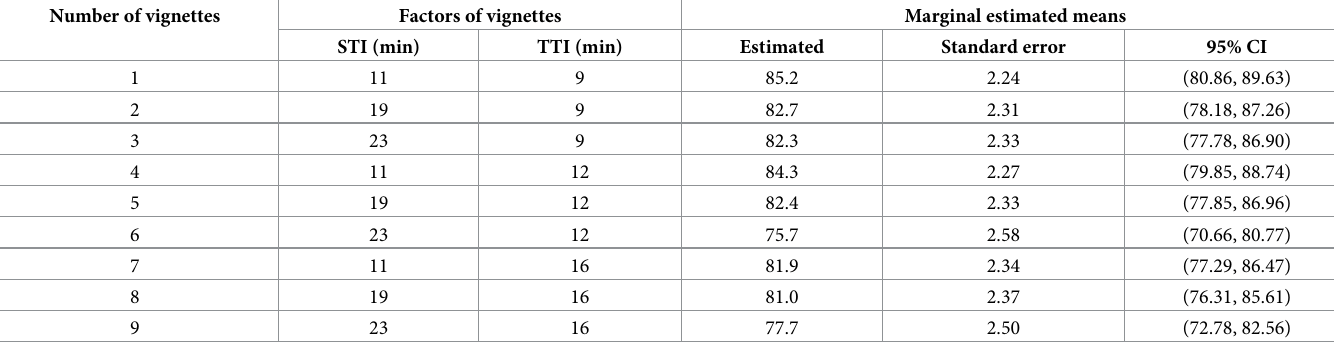
for multiple comparisons was performed (Table 4 and Fig 2). The vignette with the lowest mean willingness score was vignette 6, with an STI of 23 min and a TTI of 12 min (75.7, 95%